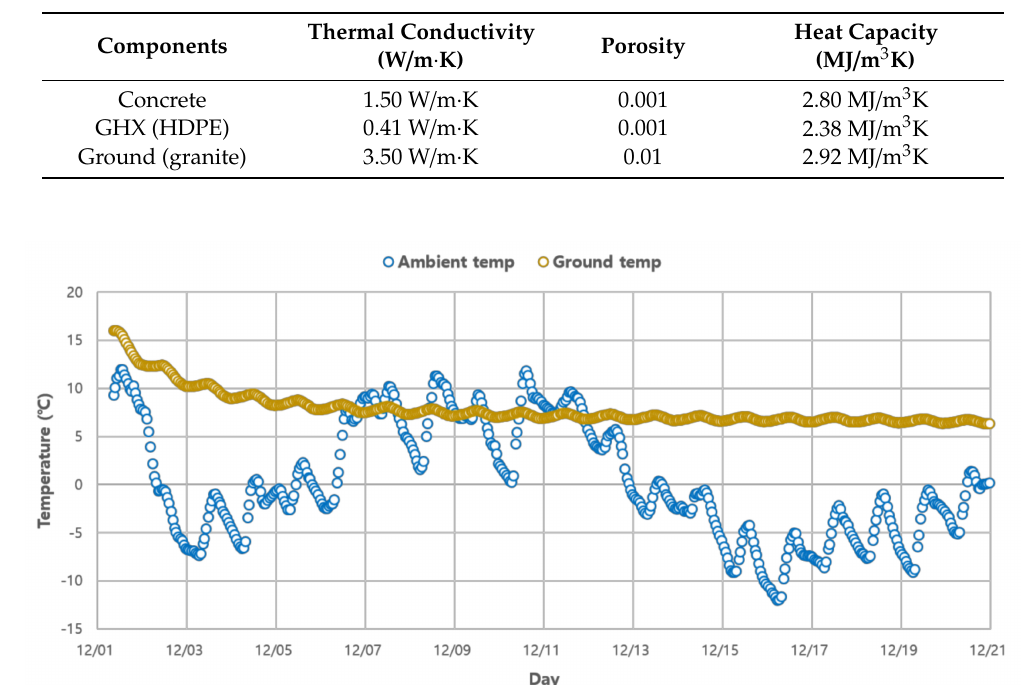
Table 2. Thermal properties.